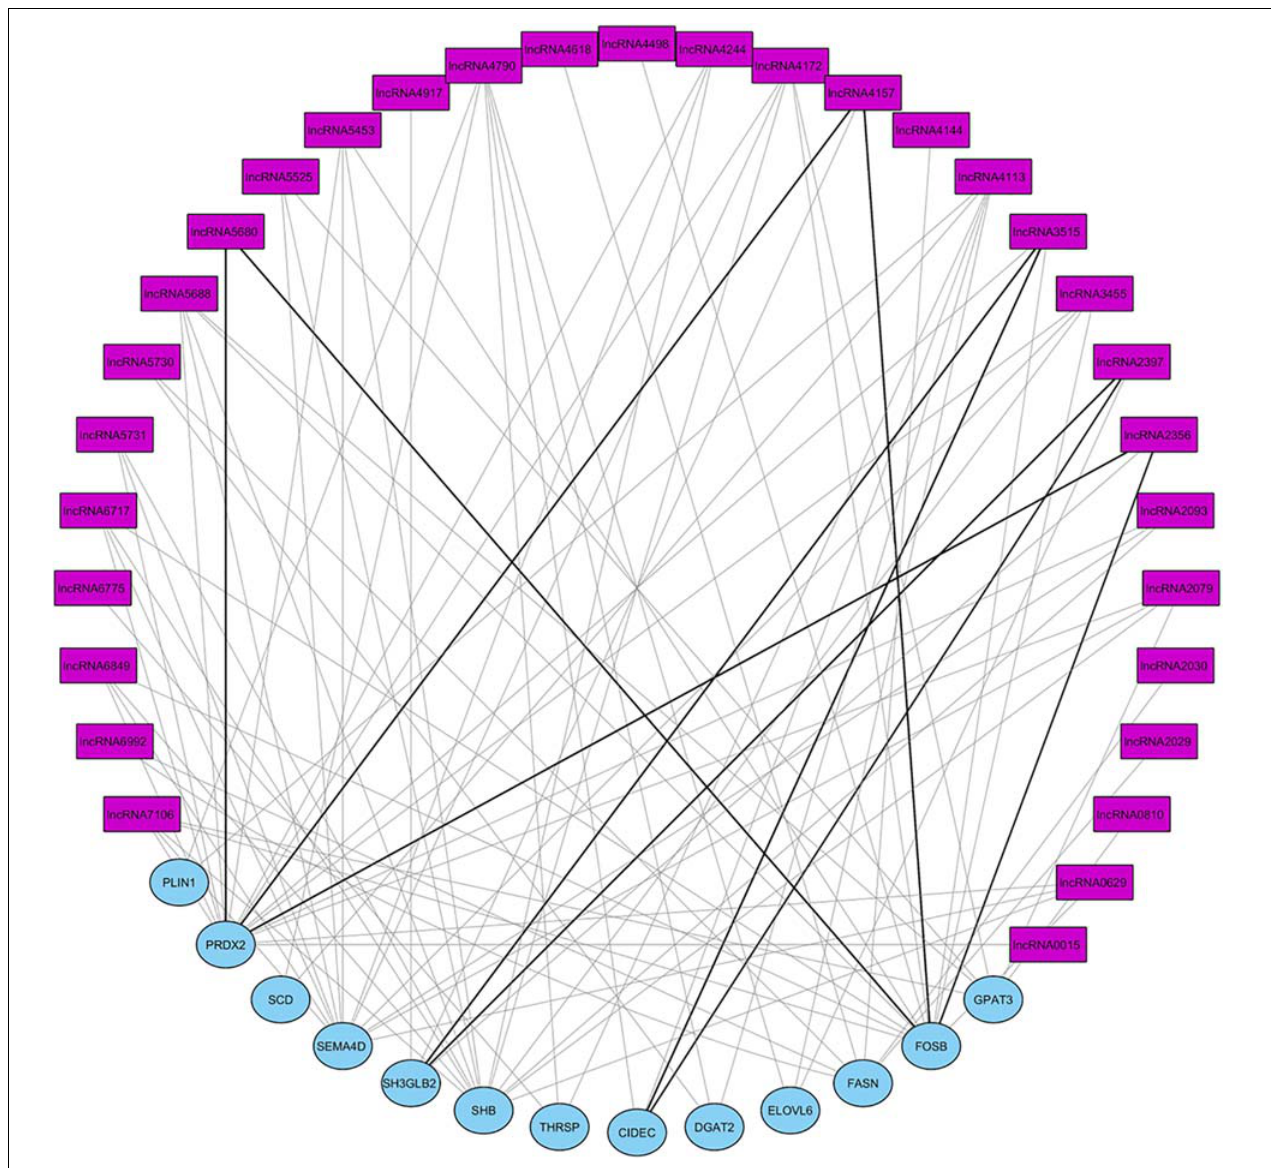
FIGURE 6 | Graphical representation of the correlations DE lncRNA and genes in network 3. Pink square nodes represent lncRNAs and blue circle nodes represent DE genes. Gray lines are positive correlations and black ones are negative correlations. lncRNAXXXX corresponds to lncRNA named in ALDB database as ALDBSSCG000000XXXX.